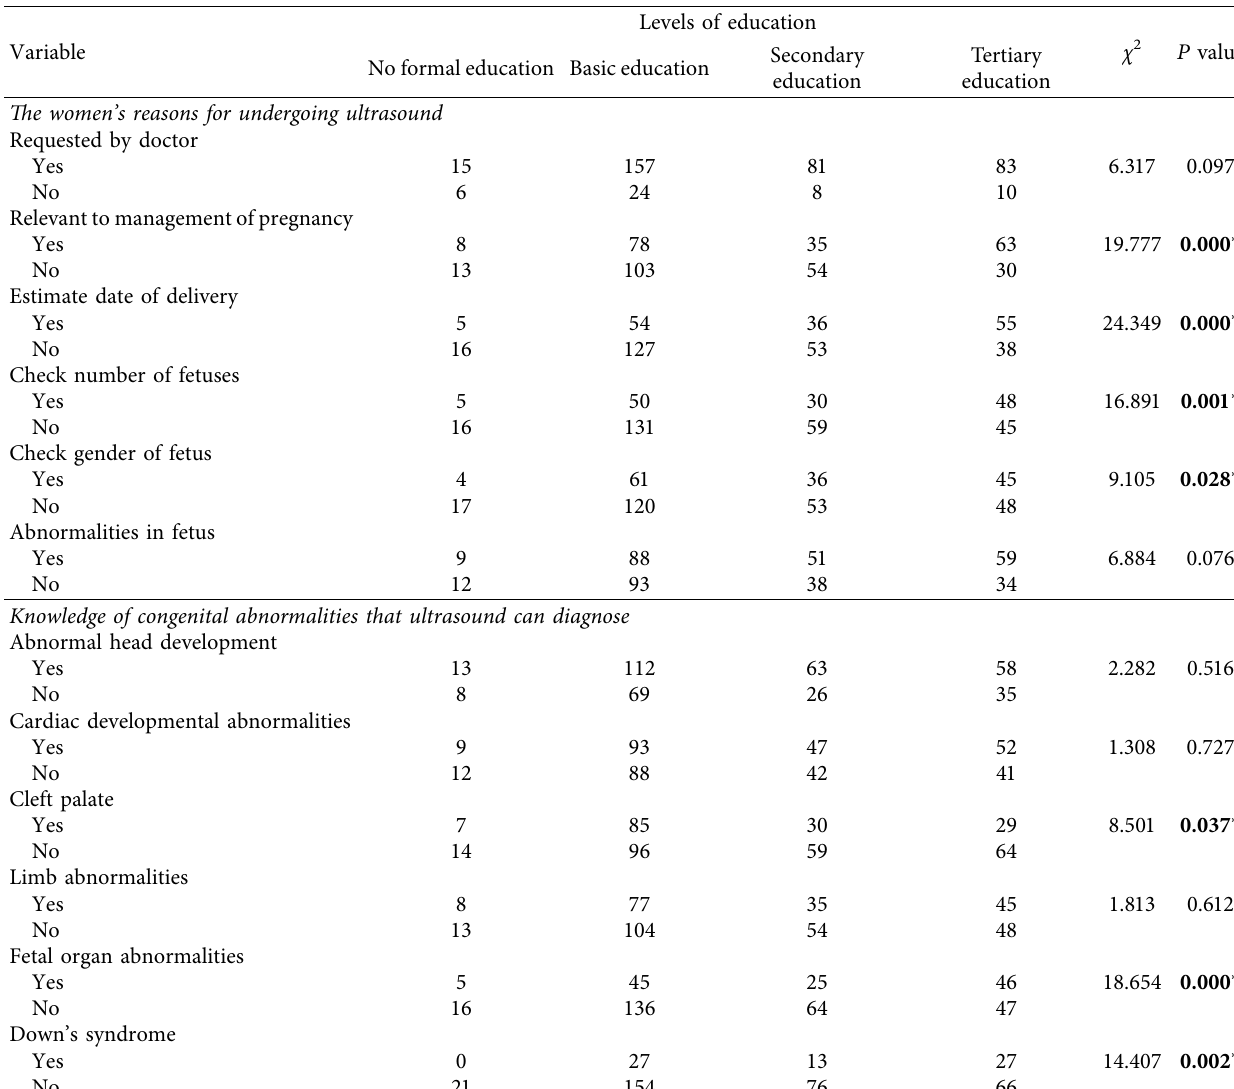
Table 6: A cross-tabulation of the levels of education of participants against women’s reasons for undergoing ultrasound scanning and knowledge of congenital abnormalities that ultrasound can